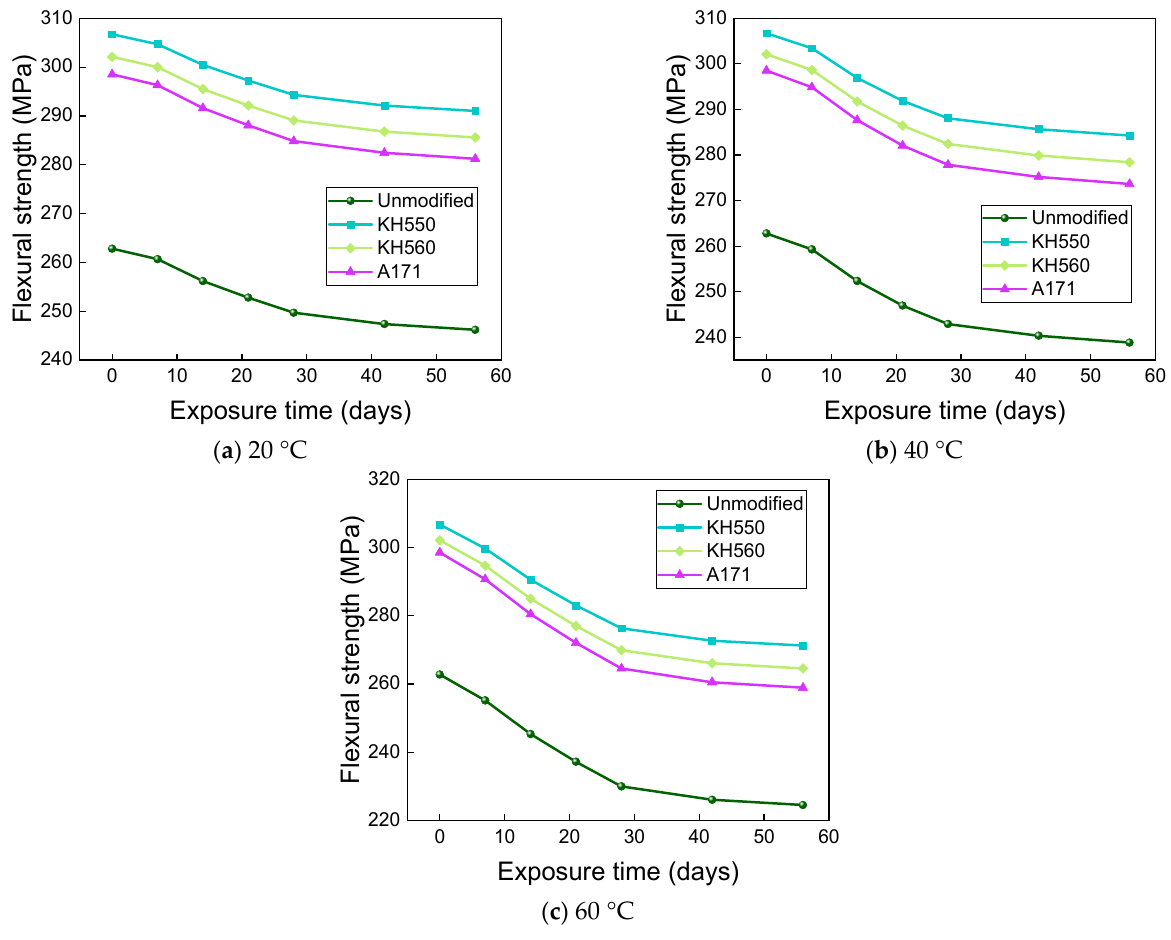
Figure 17. Flexural strength in a water environment.